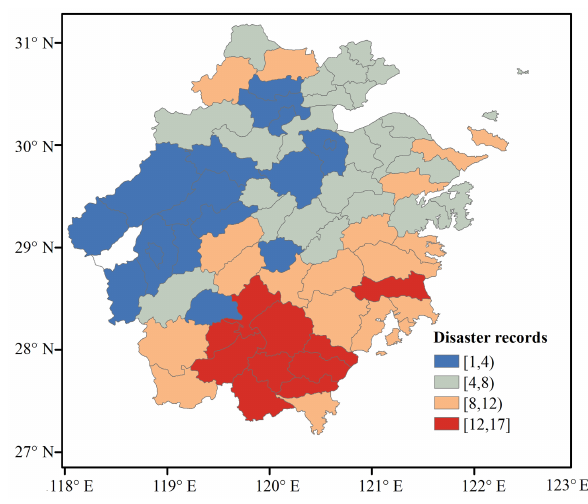
Figure 2. Number of records of typhoon disasters in Zhejiang Province from 2004 to